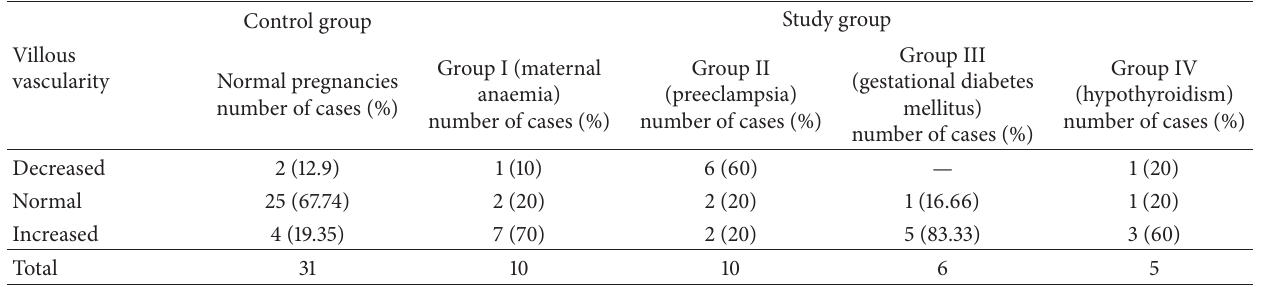
Table 3: Villous vascular changes in placentae of control and study groups.